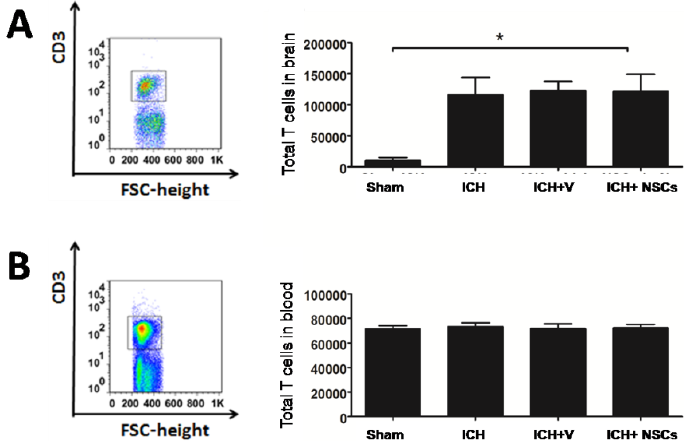
Figure 1. Total numbers of T lymphocyte cells in the brain and peripheral blood. Total numbers of T lymphocytes in the brain were significantly increased in intracerebral hemorrhage (ICH), vehicle-treated (ICH + V) and neural stem cells (NSCs)-treated groups (ICH + NSCs), compared to sham-operated group (Sham) ( A ); there was no difference of total numbers of T lymphocytes of each group in peripheral blood in ICH, vehicle-treated (ICH + V) and NSCs-treated groups (ICH + NSCs), compared to sham-operated group (Sham) ( B ), ( n = 8 in each group). * p < 0.05 versus sham ICH.